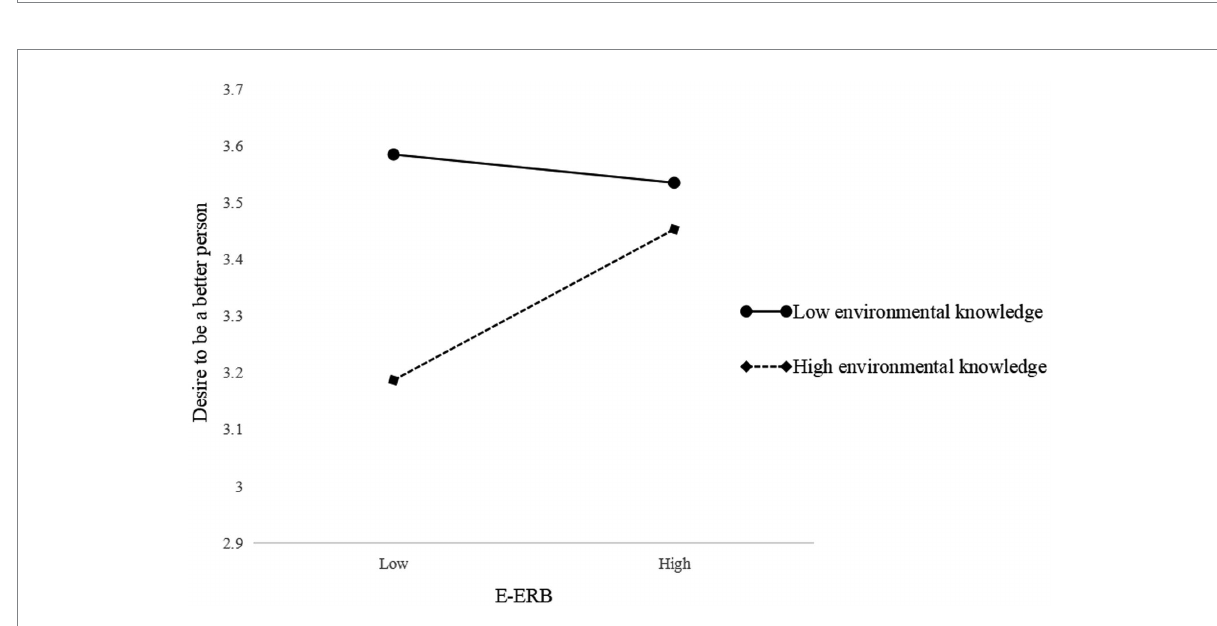
FIGURE 3 Interactive effects of E-ERB and environmental knowledge on desire to be a better